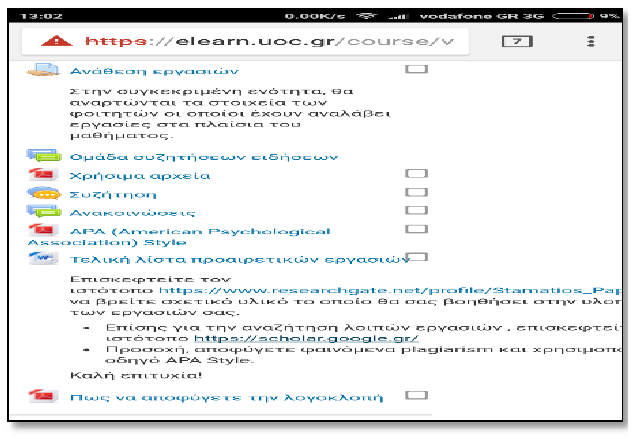
Figure 3. Moodle content in a 5.5-inch mobile device screen.